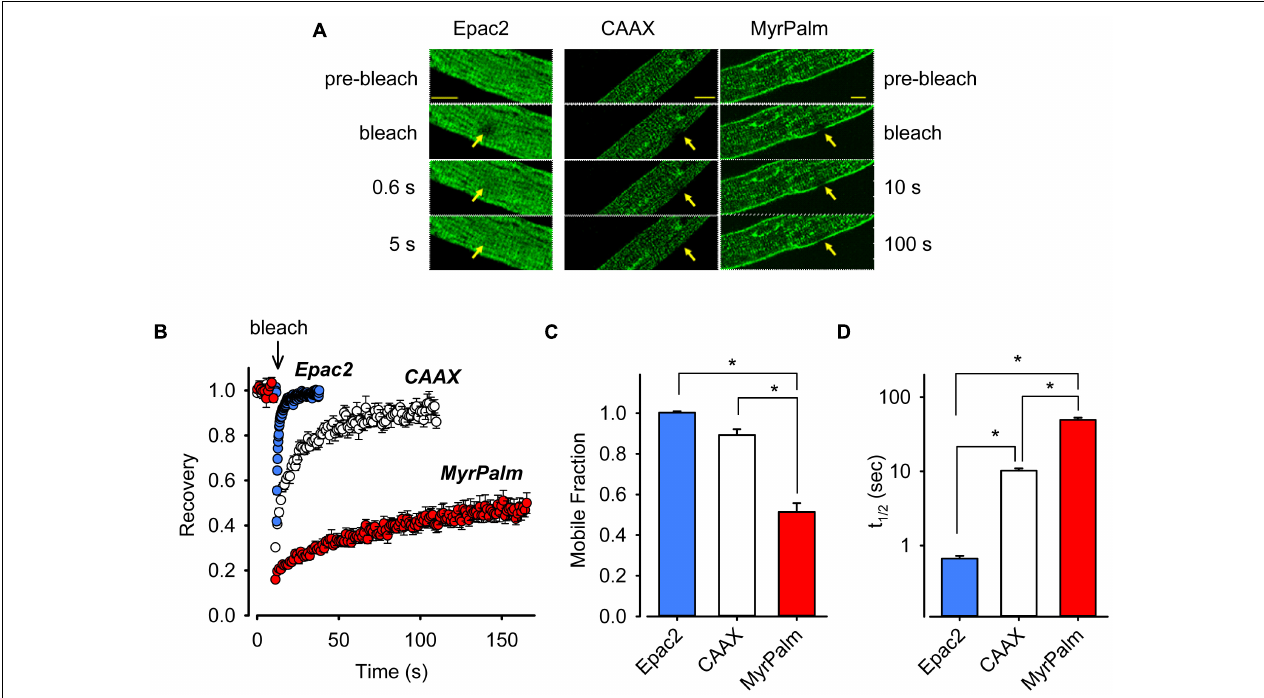
FIGURE 2 | Biosensors targeted to different subcellular locations of cardiac ventricular myocytes exhibit varying mobilities. (A) Images from FRAP experiments in adult rat ventricular myocytes expressing Epac2-camps (Epac2, left panels), Epac2-CAAX (CAAX, middle panels), or Epac2-MyrPalm (MyrPalm, right panels). Images were taken before and at various time points after bleaching of a circular area of 5 µ m in diameter (arrows). Images were captured at a greater frequency for freely diffusible Epac2 (indicated by faster recovery on the left) as compared to membrane targeted biosensors CAAX and MyrPalm (indicated by slower recovery on the right). Scale bar: 10 µ m. (B) Time course of fluorescence recovery from photobleaching from FRAP experiments in cells expressing Epac2 (blue circles), CAAX (white circles), or MyrPalm (red circles). Summary of (C) , mobile fraction (M f ), and (D) fluorescence recovery half-time (t 1 / 2 ), in cells expressing Epac2-camps (n/N = 15/4, blue bars), Epac2-CAAX (n/N = 7/3, white bars) or Epac2-MyrPalm (n/N = 8/3, red bars). ∗ p < 0.001, Kruskal–Wallis one-way ANOVA on Ranks followed by Dunn’s test for pairwise multiple